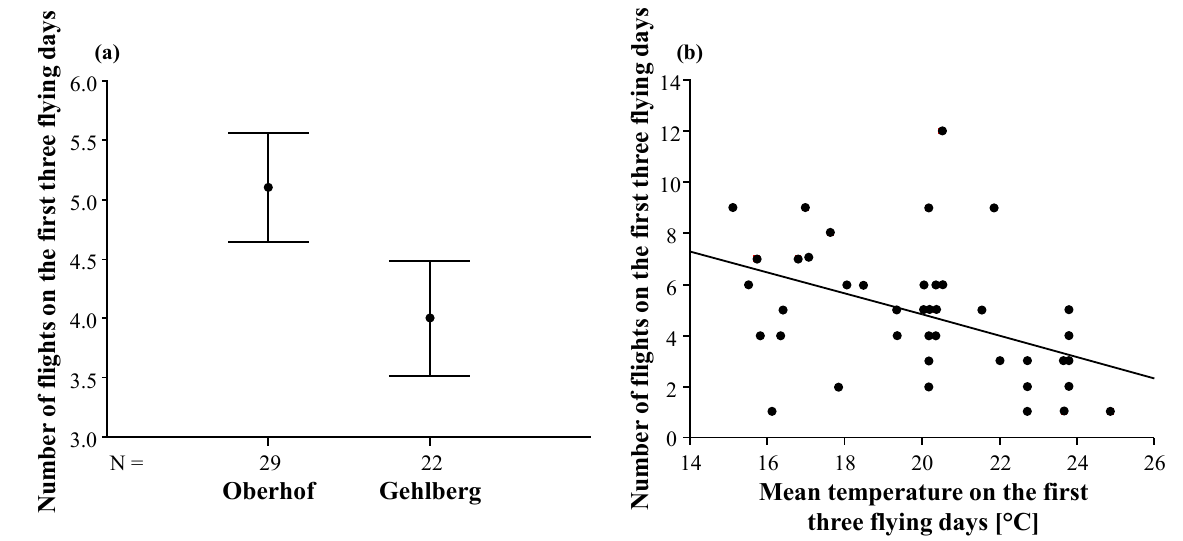
Figure 5. ( a ) Comparison of the total number of nuptial flights (on the first three flying days) at Oberhof and Gehlberg. Arithmetic mean and standard error are given for each mating apiary. N is the number of queens flying at Oberhof and Gehlberg respectively. ( b ) The total number of nuptial flights of each queen in relation to the mean temperature for the first three flying